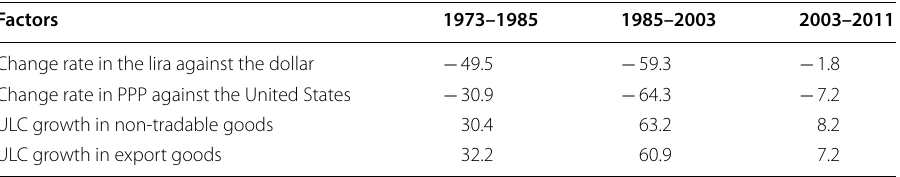
Table 1 ULC growth rates, PPP and nominal exchange rate (annual, unit: %) Source : The change rate in the lira against the US dollar was derived from the Central Bank of the Republic of Turkey. For additional information, see Fig.